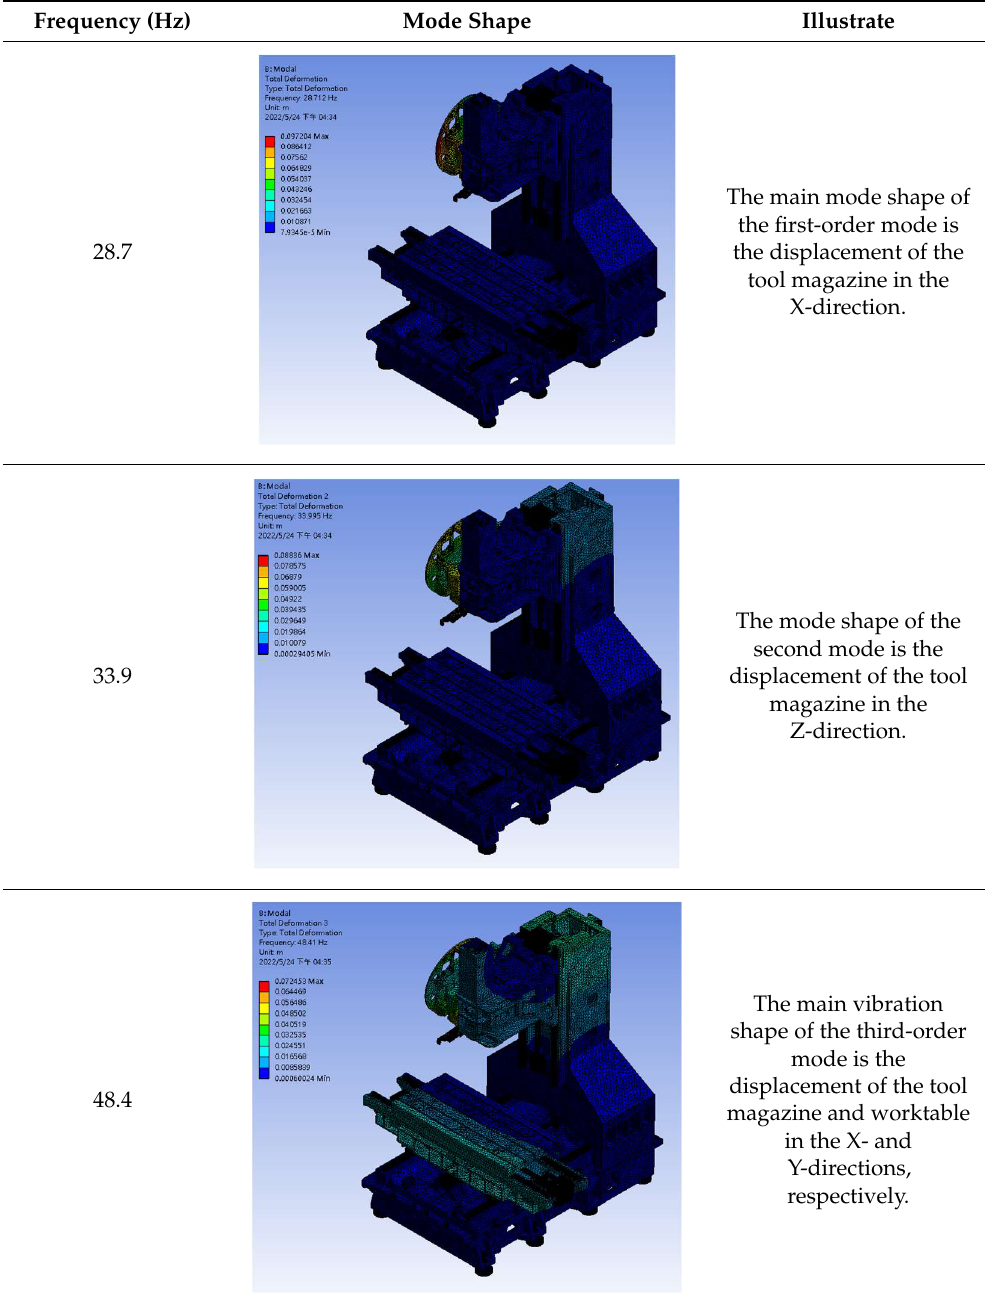
Figure 4. Static analysis